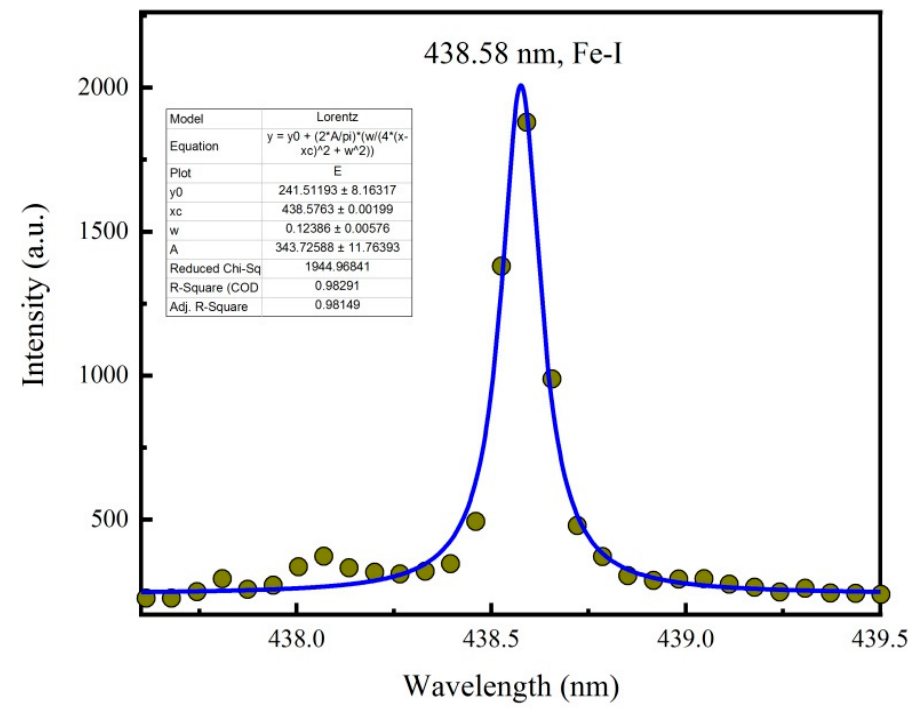
Figure 5. Stark broadened line profile of Fe-I line at 438.58 nm.